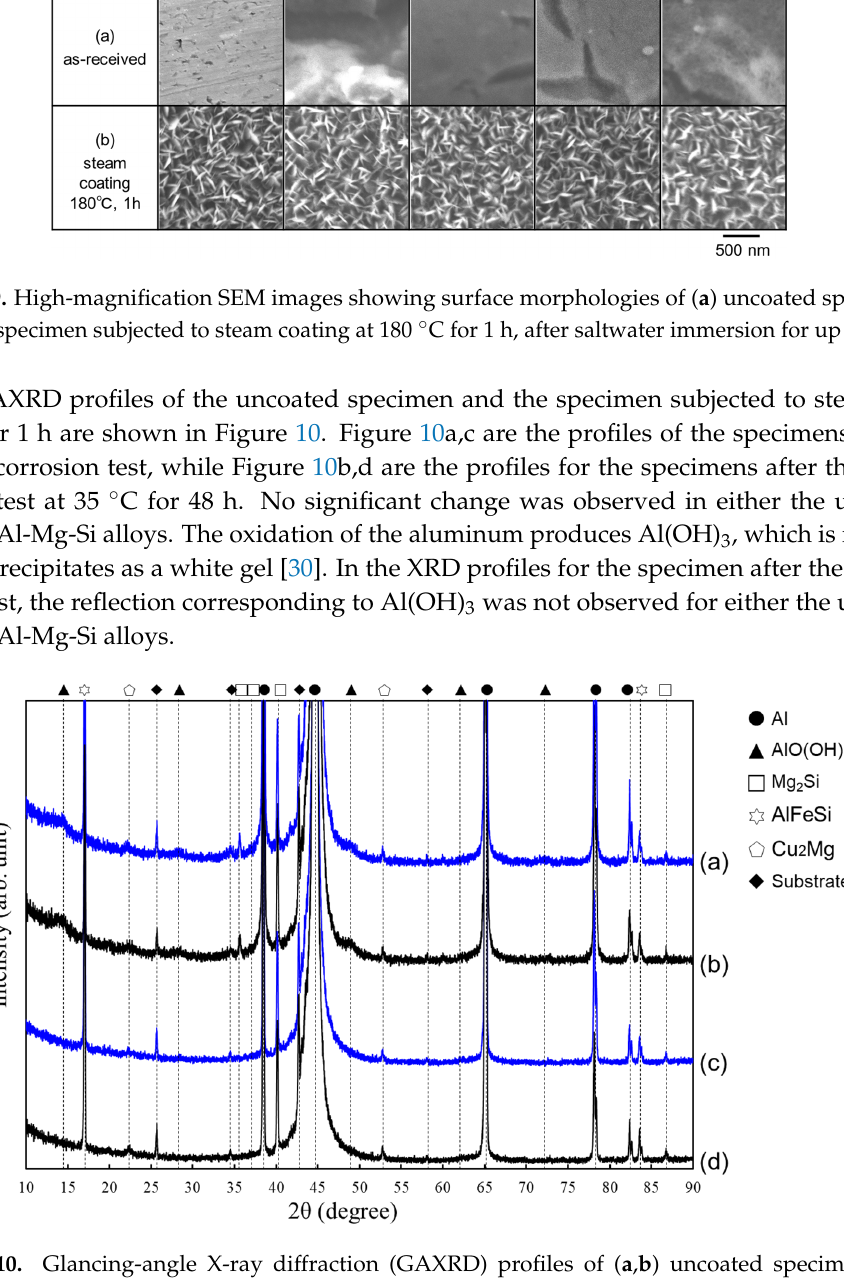
Figure 10. Glancing ‐ angle X ‐ ray diffraction (GAXRD) profiles of ( a , b ) uncoated specimen and ( c , d ) Figure 10. Glancing-angle X-ray diffraction (GAXRD) profiles of ( a , b ) uncoated specimen and specimen subjected to steam coating at 180 °C for 1 h. ( a , c ) before the saltwater immersion test and ( c , d ) specimen subjected to steam coating at 180 ◦ C for 1 h. ( a , c ) before the saltwater immersion ( b , d ) after the saltwater immersion test at 35 °C for 48 h. test and ( b , d ) after the saltwater immersion test at 35 ◦ C for 48